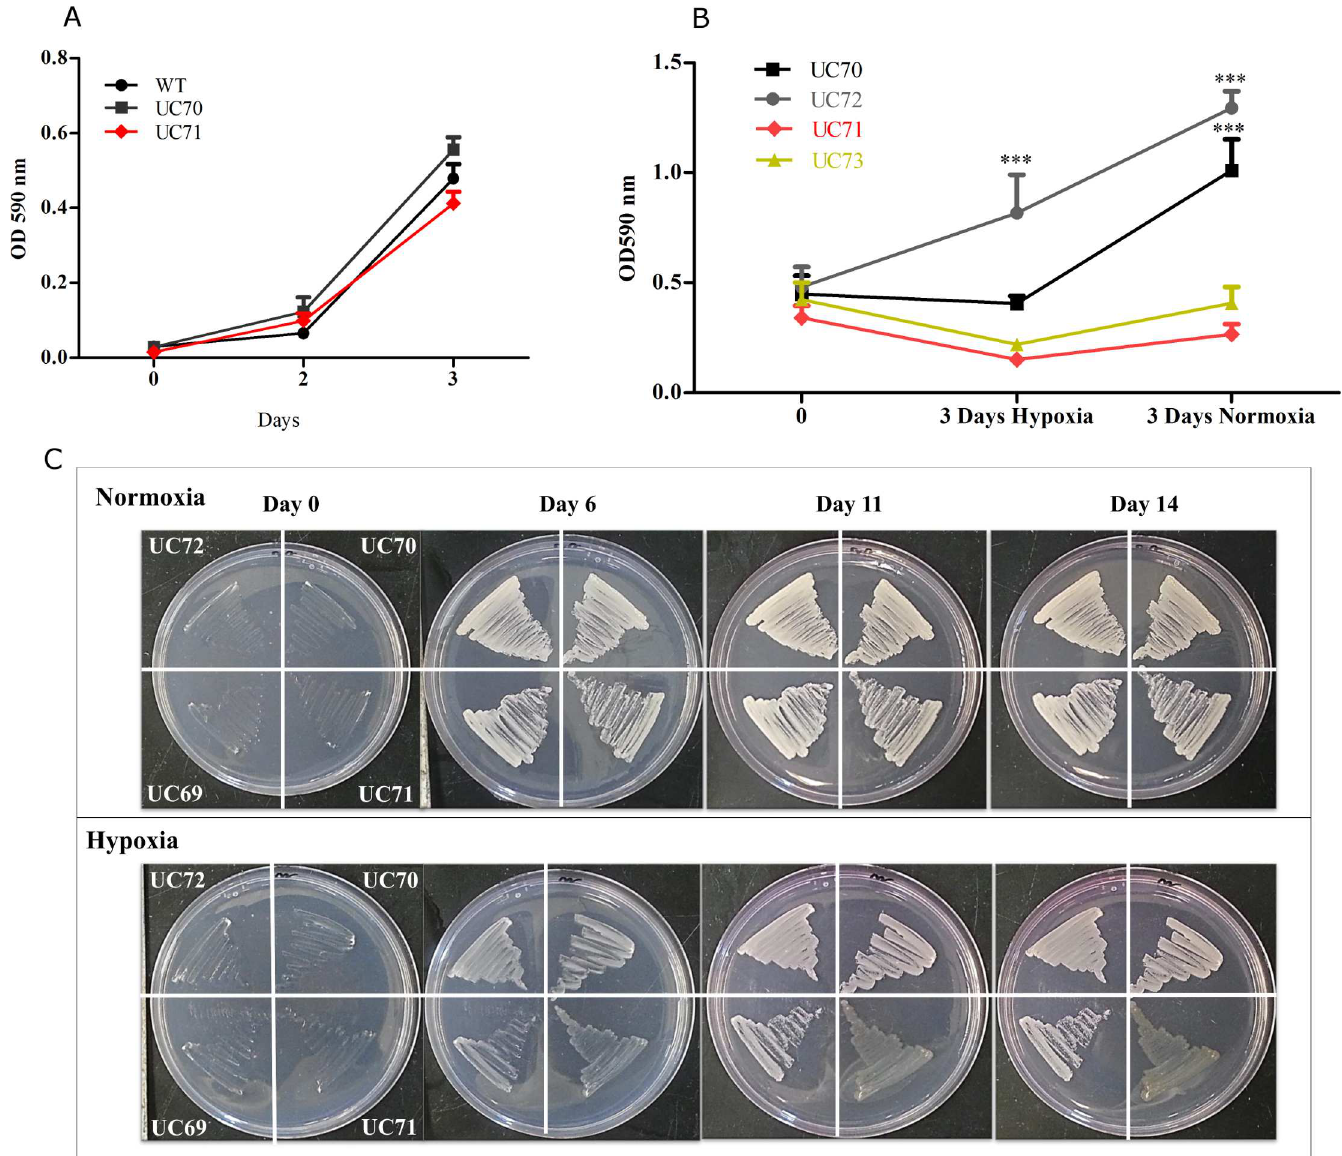
Fig 2. H . capsulat um Srb1 expression is required for hypoxic growth. (A) Growth curve of WT, UC70 ( vector :RNAi) and UC71( Srb1 :RNAi), under normoxic conditions. (B) Growth curve of UC70 and UC71 in liquid HMM after 3 days of hypoxia followedby an additional3 days of normoxia. Yeasts were inoculatedwith 5x10 6 /ml of HMM. ( C) Growth pattern of wild-type-vector strains UC70 and UC72, and Srb1 :RNAi strains UC71 and UC69 streaked onto HMM plates supplemented with blasticidinand cultured for 14 days. ( D) After 11 days of hypoxia HMM plated yeasts were placed under normoxia for an additional11 days (i) or re-streaked and placed under hypoxia (iii) or normoxia (ii) for 11 days. Data shown are the results of 3–4 experiment and representedas mean ±